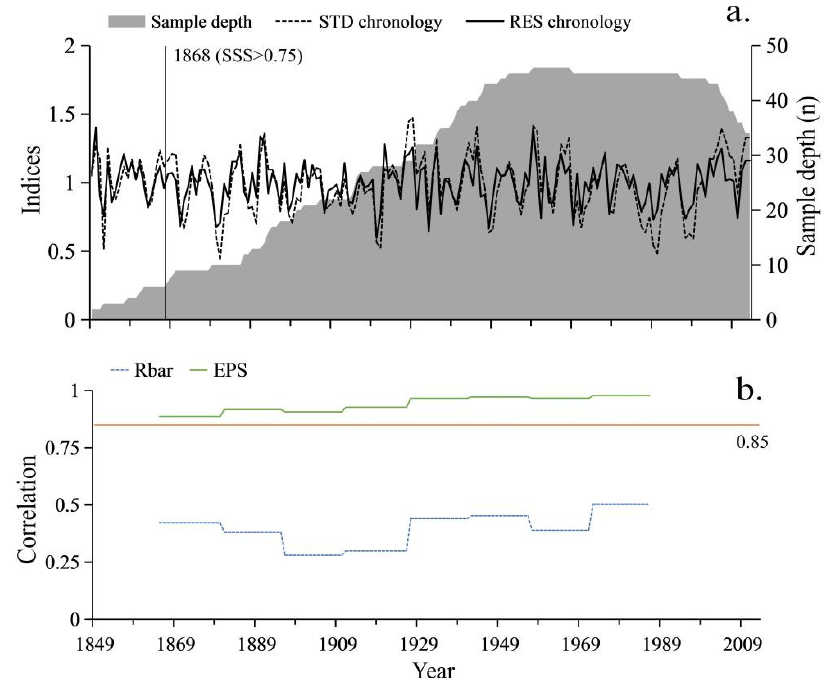
Figure 2. The curves of residual chronology (RES), standard chronology (STD) and sample depth ( a ). The EPS (expressed population signal, blue line) and Rbar (average correlation between series, green line) over a 30 ‐ year running window with 15 ‐ year overlaps ( b ). Rbar ranges from 0.28–0.50, EPS ranges from 0.88–0.98. EPS value is higher than 0.85 from 1865. The vertical line indicates that the acceptable (valid) time for tree ‐ ring width chronology for estimation starts at 1868 (SSS > 0.75). The orange horizontal line is the 0.85 cutoff for EPS.